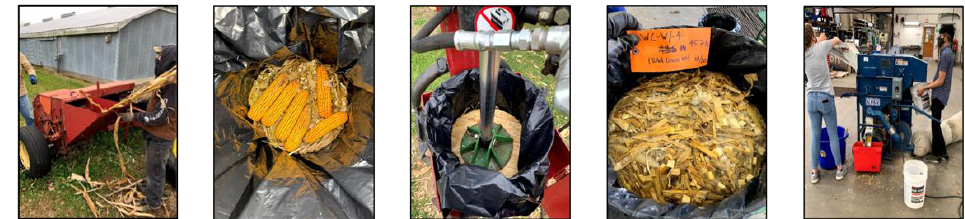
Figure 1. The process to assess the potential of anaerobic storage of ear corn. Starting at the left: chopping the stover with a stationary chopper, placing chopped stover and ears into a plastic-lined barrel, compressing with a hydraulic press to achieve the desired packing density, removing from storage, and shelling the ears with an ear sheller to determine grain damage.